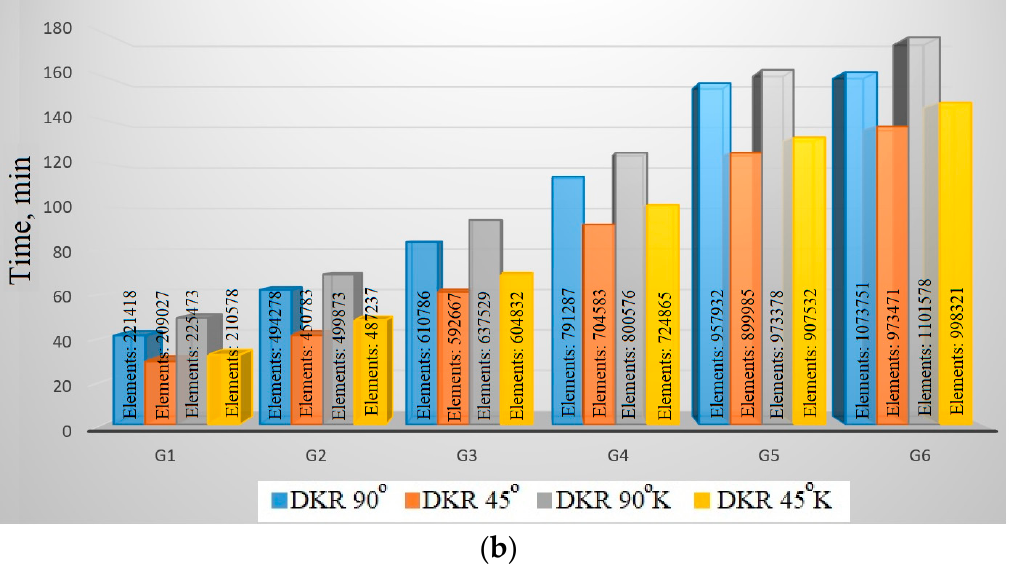
Figure 5. Views of the numerical simulation model for angular fitting connections (2/2): ( a ) mesh resolution; ( b ) summarised results from grid independence study.